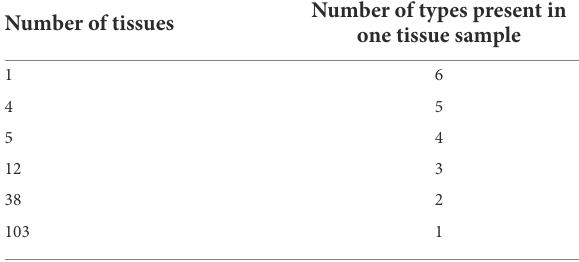
TABLE 4 Statistical comparison of Borreliella type G (strain 72a) using logistic regression. Odds